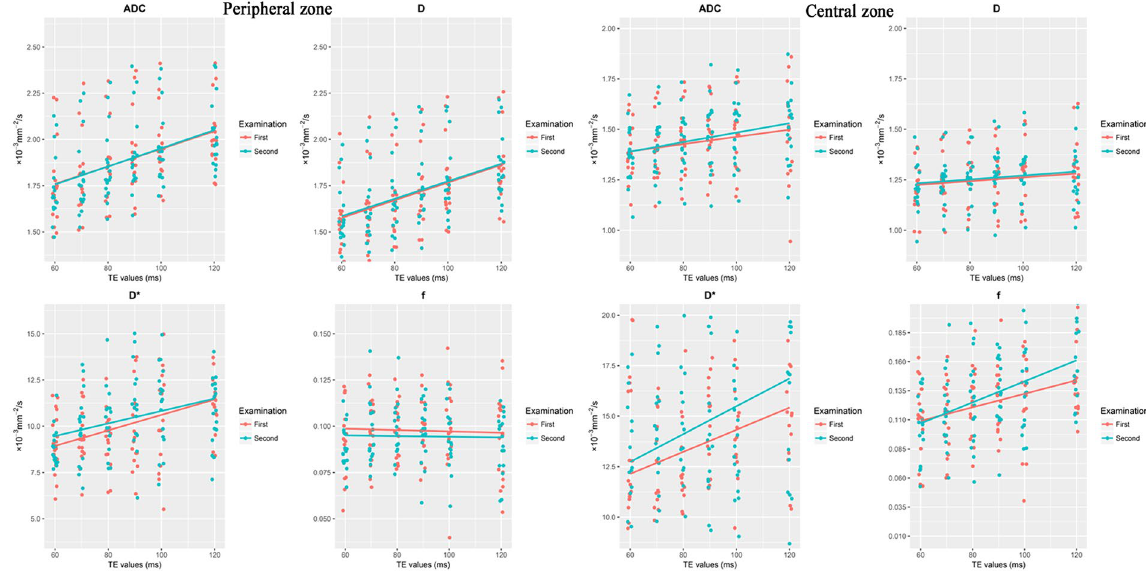
Figure 1. The scatter plot distribution of ADC, D, D * , and f according to the TE value. In the peripheral zone, ADC, D, and D * increased as TE increased, while f was stable. In the central zone, the ADC increased, but not obviously, with increases in TE, while D was stable as TE increased. The D * and f values increased as TE increased. Jittering (width = 1 ms, height = 0 ms) was applied to reduce